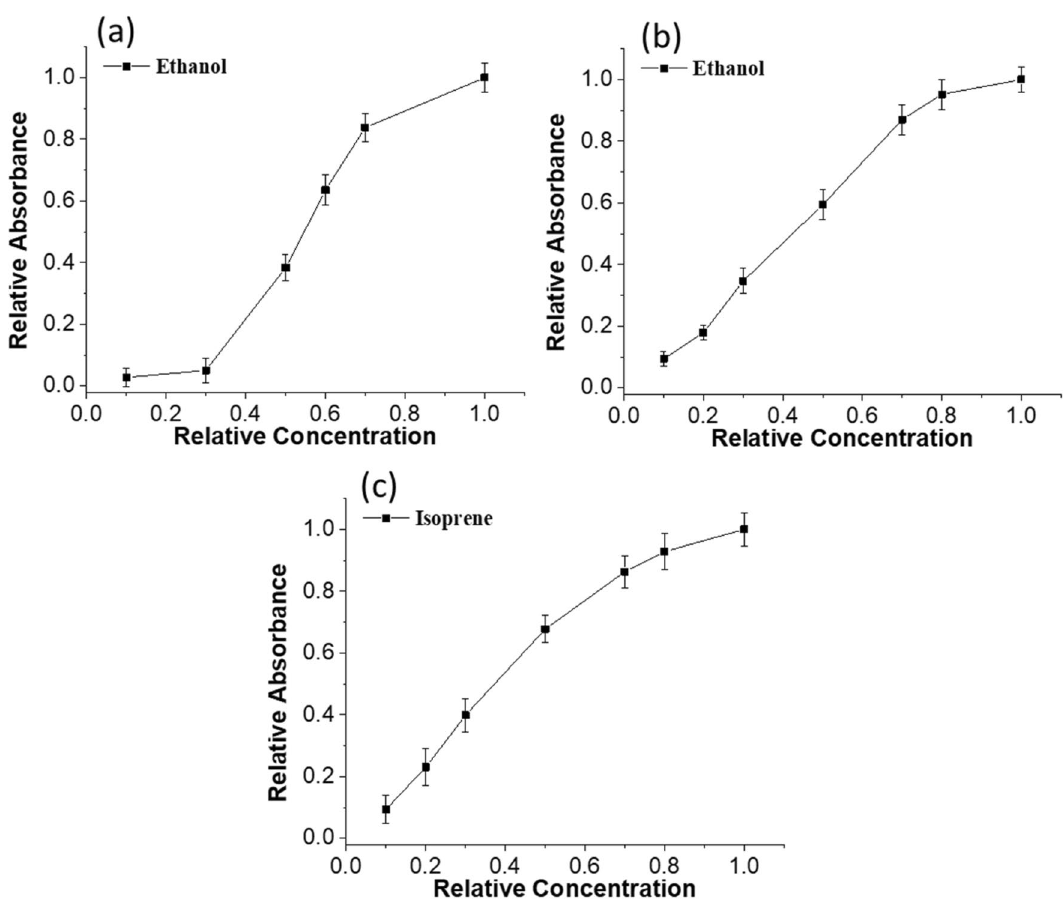
Figure 10. Relative absorbance vs relative VOC concentration for ( a ) acetone at λ = 3.375 µm, ( b ) ethanol at λ = 3.375 µm, and ( c ) isoprene at λ = 3.400